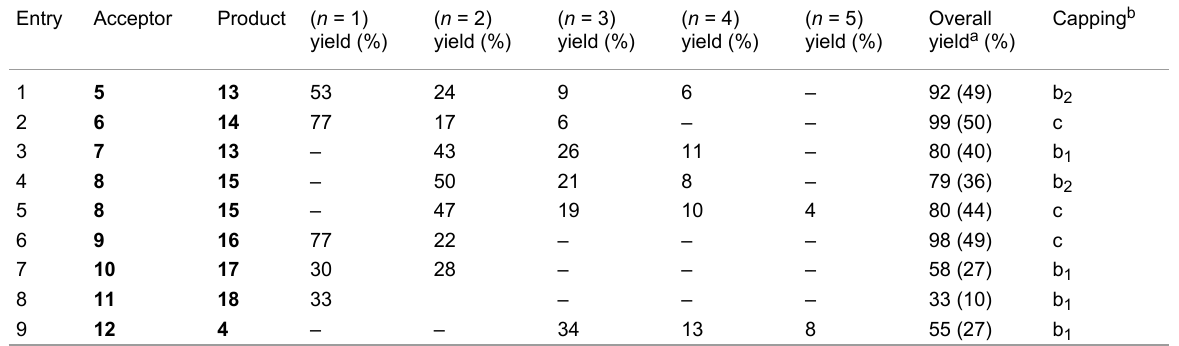
Table 2: Oligomerizations with variations in initiating